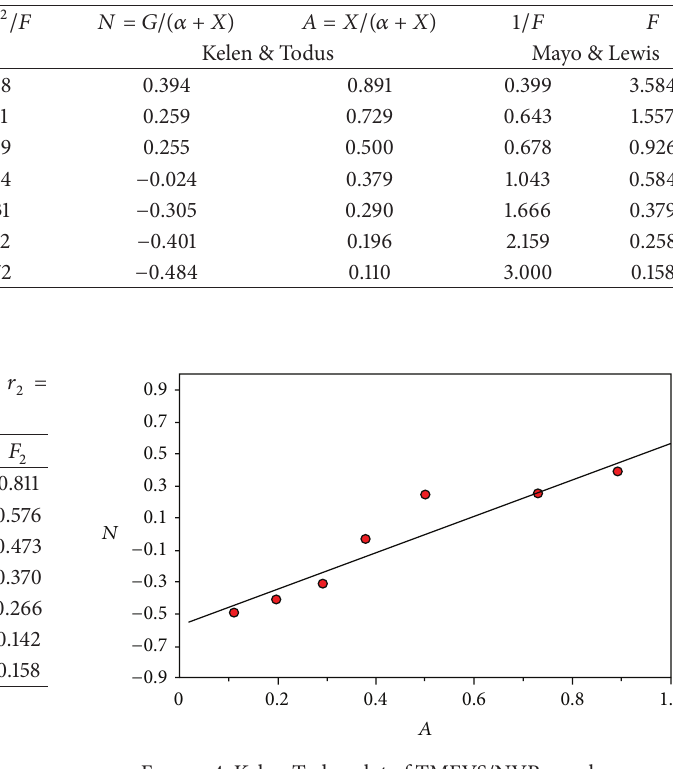
Figure 4: Kelen-Tudos plot of TMEVS/NVP